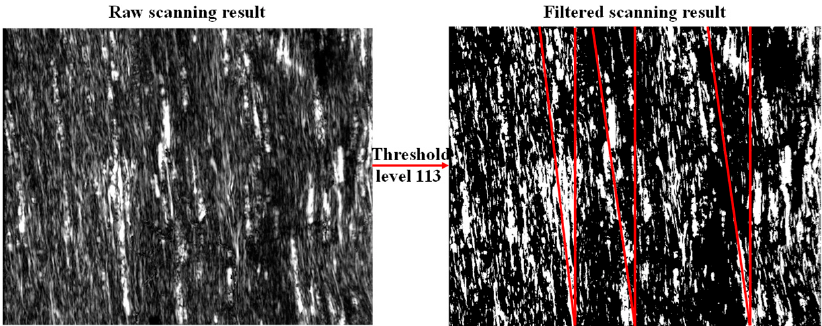
Figure 10. Ultrasound C-scan imaging of UD.